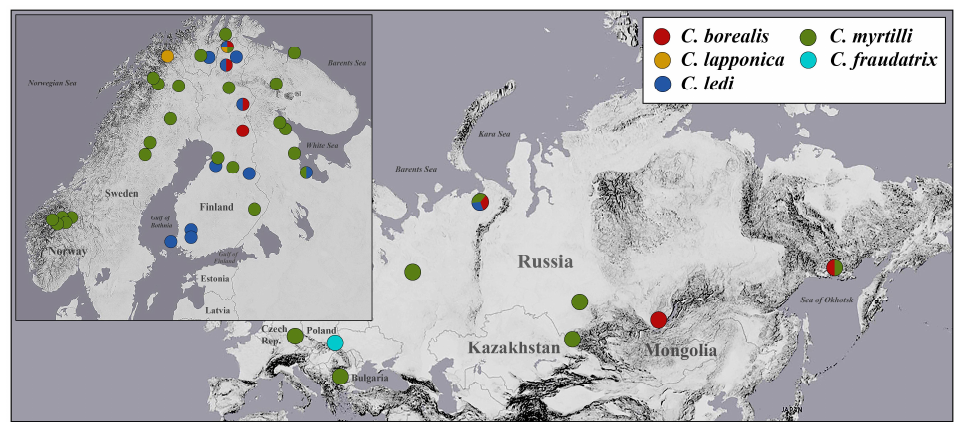
Figure 1. Map showing sampling localities of the analyzed specimens of Cacopsylla.